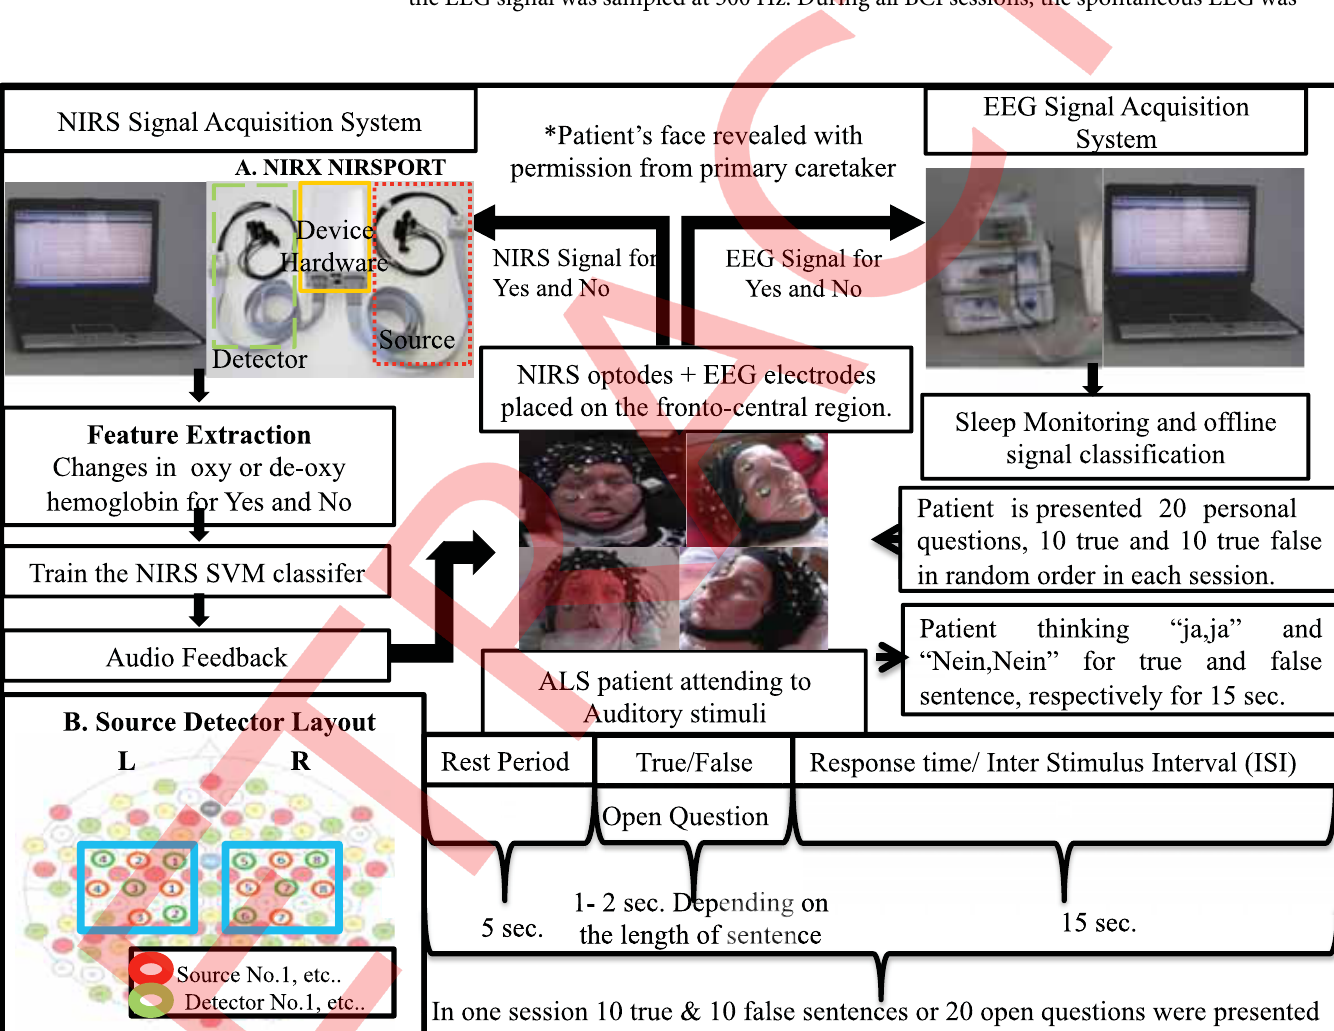
Fig 6. The procedure and flow diagram of the brain–computer interface (BCI) for communication in ALS patients. (A) The continuouswave-based portableNIRX NIRSport instrument. The device consists of eight near-infrared light sources (highlightedin red), eight detectors (highlightedin green), and the NIRS data acquisitionhardwareis highlighted in yellow. (B) Depicts the placementof sources and detectors (optodes) on the frontocentralregionof the scalp (blue). Four sources (highlightedin red) and four detectors (highlightedin green) were placedon each hemisphere to form a channel.